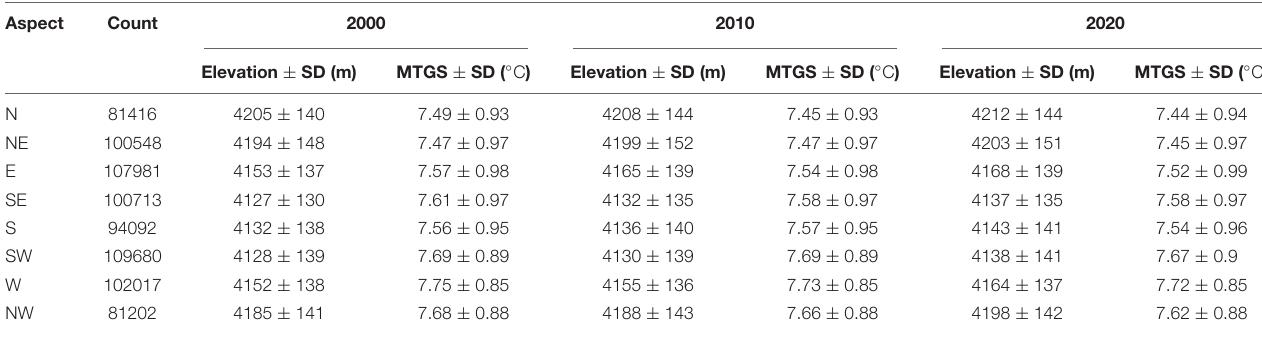
TABLE 1 | Numerical statistics of treeline grids in each slope